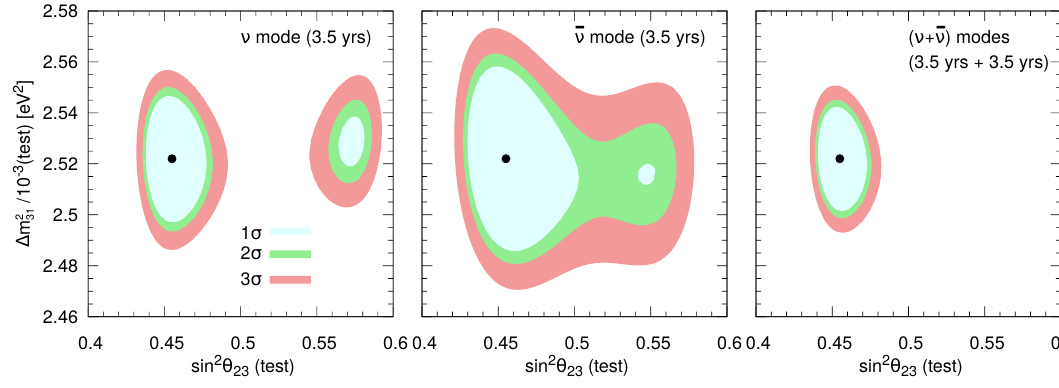
) plane at 1 σ (blue), 2 σ (green), and 3 σ (red) Figure 14 . Allowed regions in the test ( sin 2 θ 23 - ∆ m 2 31 C.L. combining appearance and disappearance data in DUNE. Left (Middle) panel is for 3.5 years of neutrino (antineutrino) run. The right panel shows the performance of combined neutrino (3.5 years) and antineutrino (3.5 years) runs. The black dot depicts the true choices of sin 2 θ = 0 . 455 23 and ∆ m 2 = 2 . 522 × 10 − 3 eV 2 assuming true NMO and δ = 223 ◦ . In the fit, we marginalize over CP 31 the current 3 σ range of δ = [139 ◦ : 355 ◦ ] and the rest of the oscillation parameters are kept fixed CP at their present best-fit values as shown in table